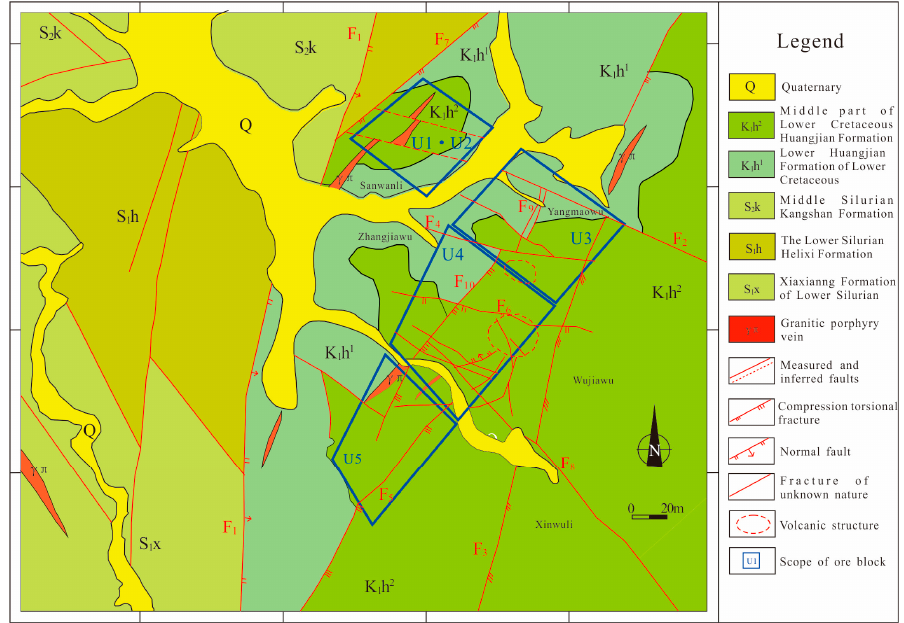
Figure 2. Geological sketch map of the Zhangjiawu mining area in northern Zhejiang Province, China (U1, U2, U3, U4 and U5 refers to different uranium sections respectively).